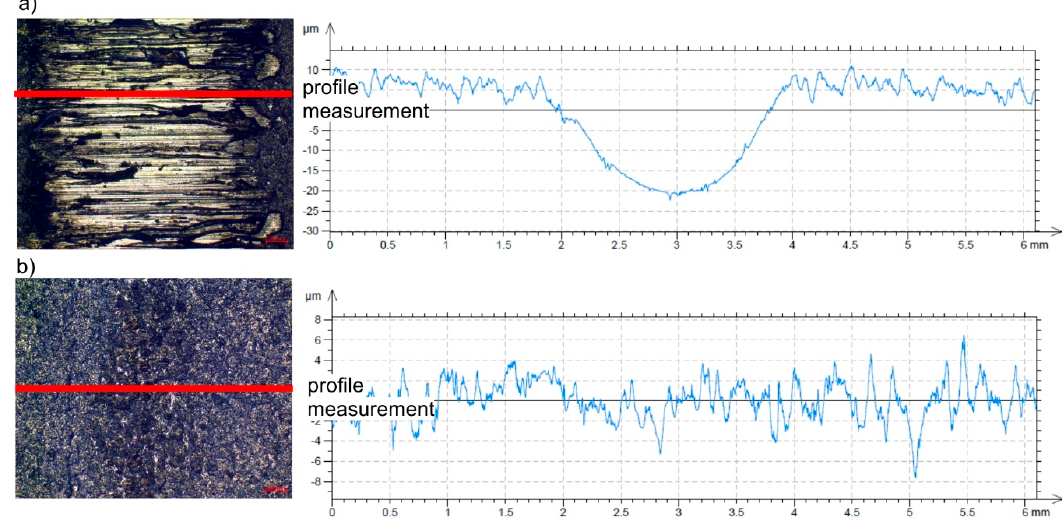
Figure 4. View and profile of the friction marks formed on the surface of the samples during friction and wear tests (T-05 tester): ( a ) 1.2344 tool steel specimen, ( b ) AlCrN-coated steel specimen.